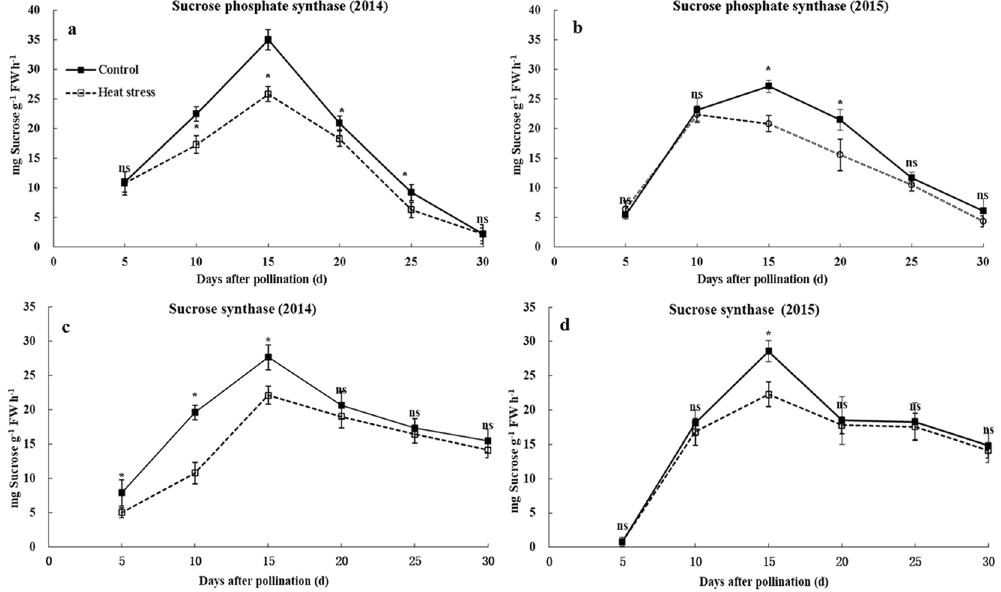
Figure 6. Activities of SPS and SuSy during grain filling under ambient and high-temperature conditions. ( a , c and b , d ) indicate the activities of SPS, SuSy in 2014 and 2015, respectively. Bars denote standard errors from three replicates, and one-way ANOVA was used to test for significance at p < 0.05